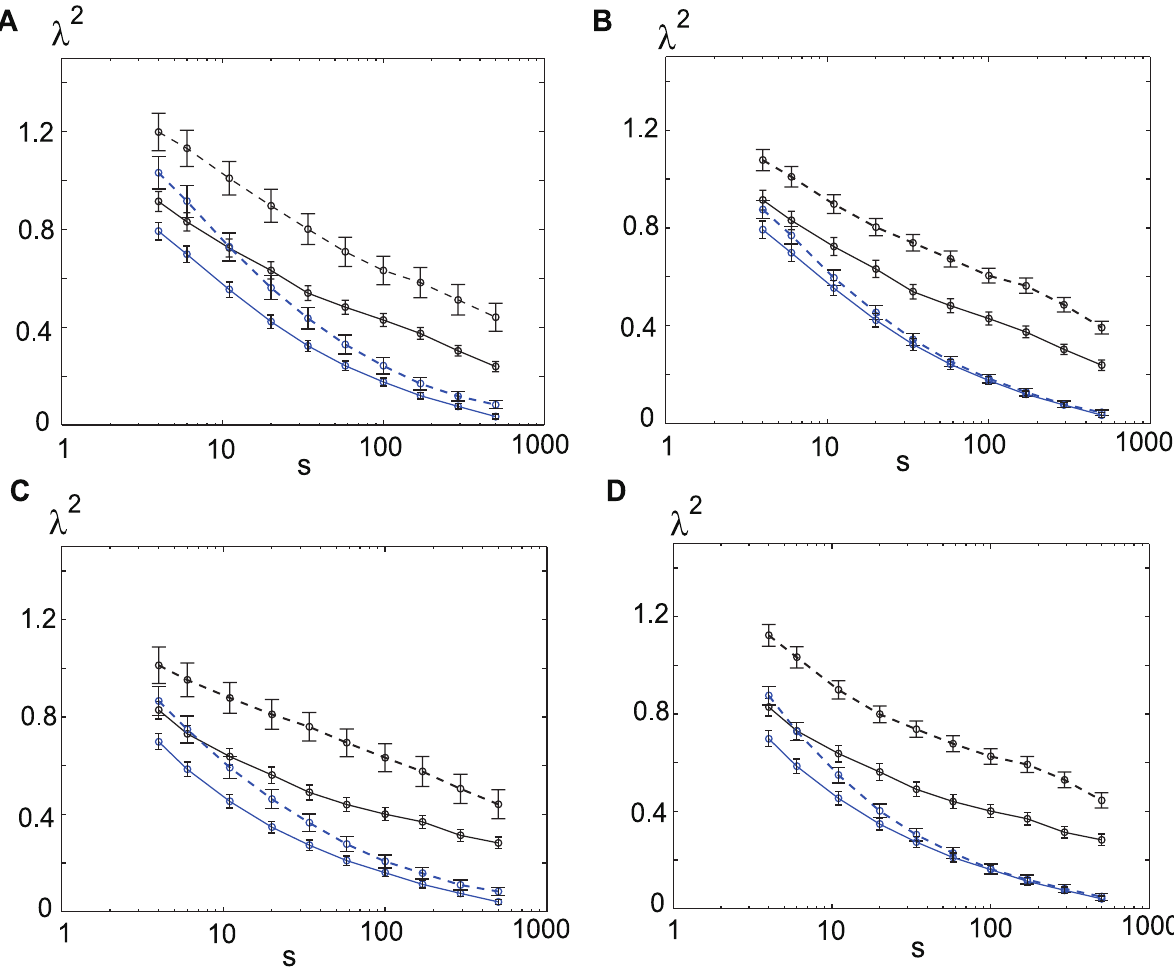
Figure 6. The l 2 values for a single tetrode and a single neuron are comparable. (A) The l 2 value of a single-tetrode spike train (defined precisely in the text) is calculated for each tetrode. The mean of l 2 values of 23 tetrodes is plotted in black with error bars indicating the standard errors. The dashed (solid) lines indicate the l 2 values during waking (sleeping) periods, while the blue lines indicate the l 2 values calculated from randomly shuffled ISIs, in all the panels. (B) The l 2 values of a single-neuron spike train are calculated for each neuron and the mean of the l 2 values of 266 neurons is plotted. Panels (C) and (D) are the same as (A) and (B), respectively, except that the moment value, q , of the l 2 estimator was set to 1 : 6 in (A)(B) and to 0 : 1 in (C)(D). p value calculated by a paired t-test (awake vs asleep) for each case and scale is very small, showing the highly significant wake/sleep difference: (A) 9.9e-05, 5.7e-05, 1.9e-04, 1.0e-03, 4.0e-03, 1.7e-02, 9.8e-03, 1.9e-02, 4.4e-02, 7.2e-02, (B)3.2e-07, 6.4e-08, 8.2e-10, 1.1e-09, 1.6e-13, 8.2e-13, 2.3e-13, 1.4e-14, 3.9e-13, 3.0e-10, (C)2.4e-08, 8.1e-09, 7.0e-09, 4.5e-08, 2.0e-07, 8.3e-06, 3.7e-05, 4.5e-04, 8.5e-03, 3.1e-02, (D)1.4e-25, 4.6e-22, 5.5e-25, 7.1e-21, 8.6e-22, 3.7e-20, 6.8e-19, 1.6e-18, 2.4e-16, 9.9e-11.